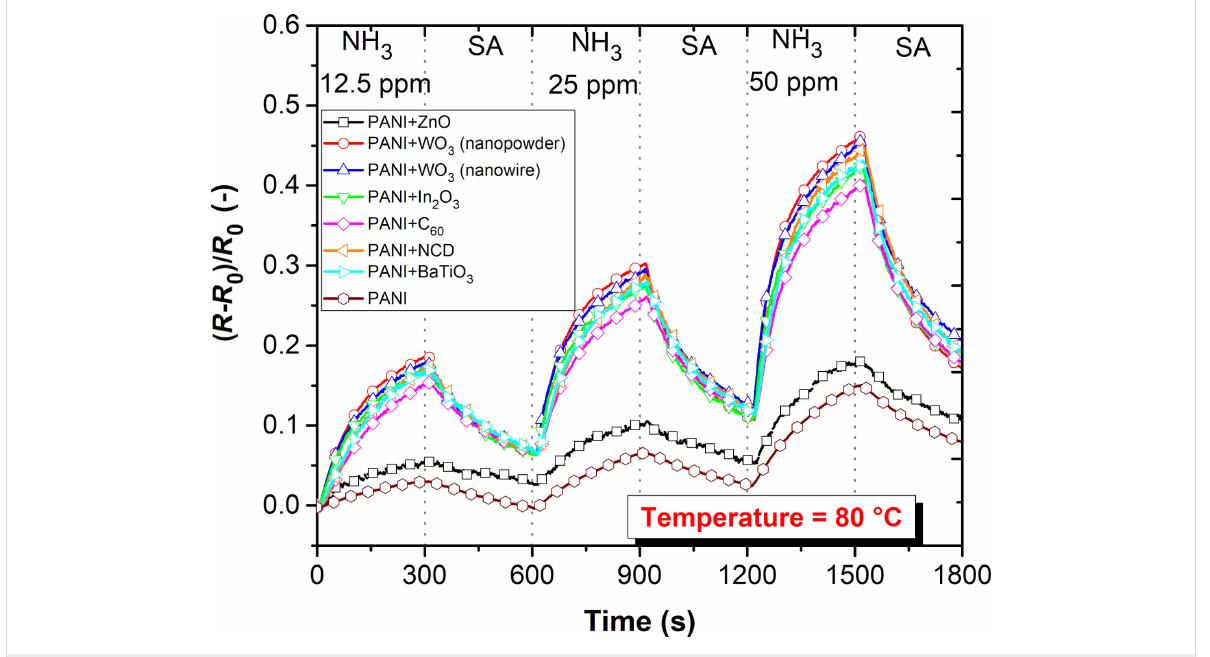
Figure 8: Gas characterization of active layers to different concentrations of NH 3 at 80 °C.